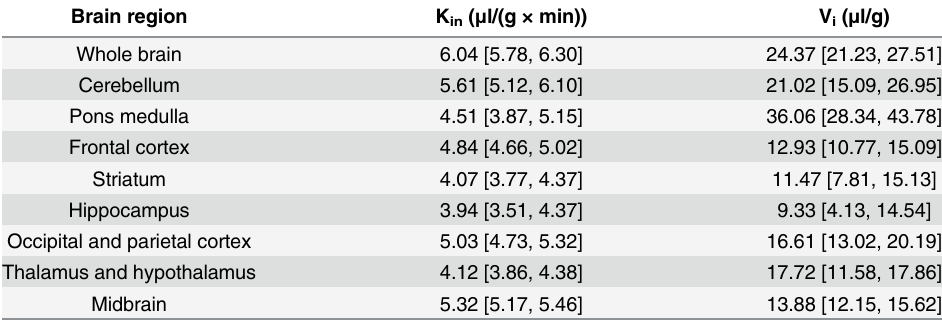
Table 3. K in and V i values of the whole brain and eight brain regions of pVEC (between brackets the 65% confidence interval is indicated).